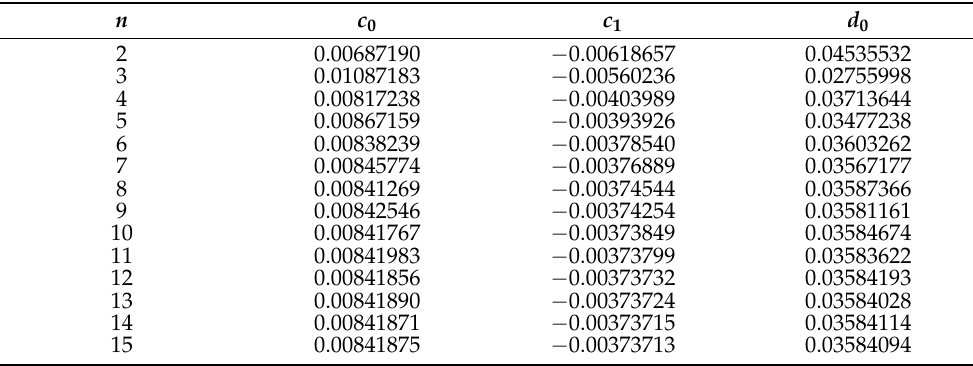
Figure 10. Variation of d i ( α − β ) i with i . Table 1. The results of numerical calculation of c 0 , c 1 and d 0